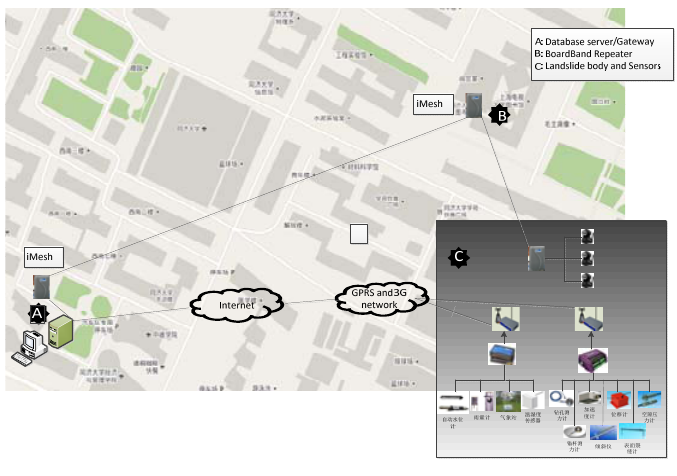
Figure 6. Diagram of sensor data communication